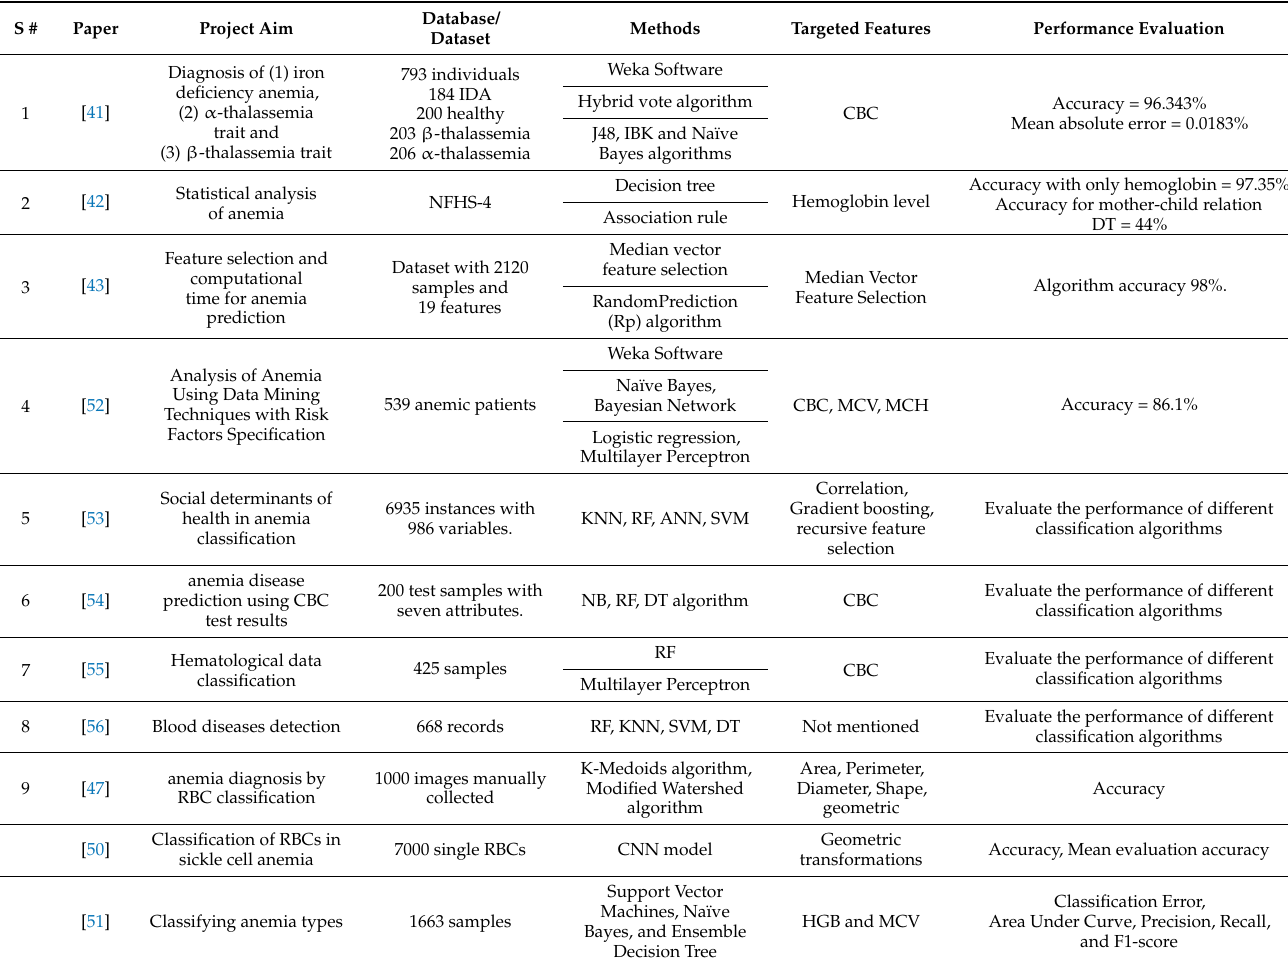
Table 1. Summarizes the anemia prediction techniques and datasets used for RBC detection. It also shows the relevant test and performance evaluation matrices commonly used for image segmentation and classification.